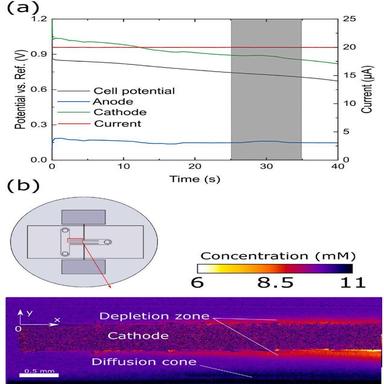
(a) MFC electrochemical parameter during the measurements of the concentration field at 20 μA. The grey rectangle indicates the time period used to average the imaging data. (b) The steady state concentration field imaged at the inlet of the cathode (see the red rectangle in the MFC insert).